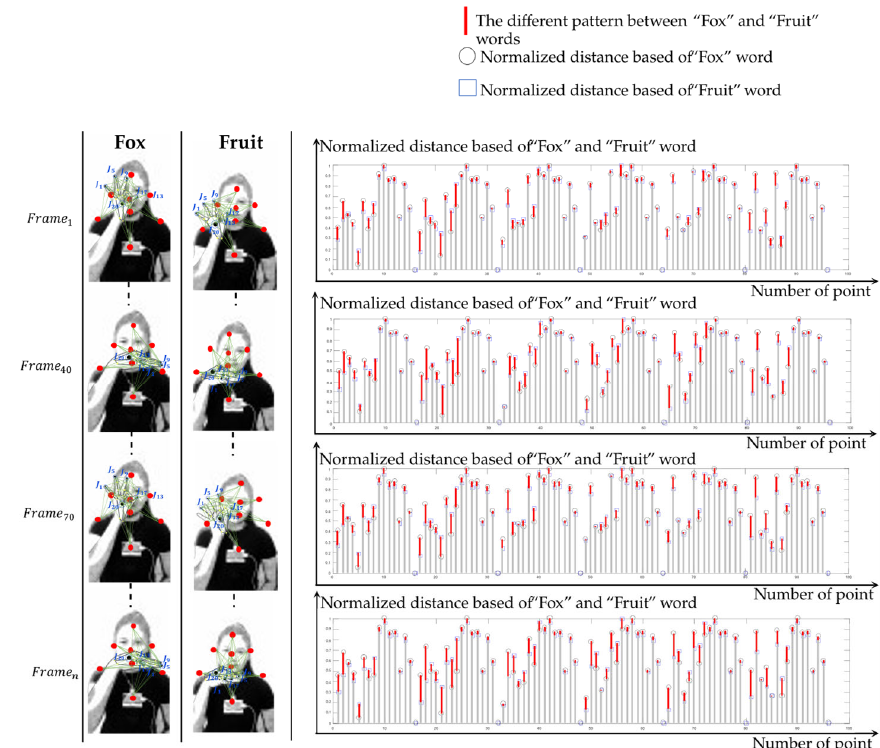
Figure 4. Comparison of similarly signed words using H 1 ( t )